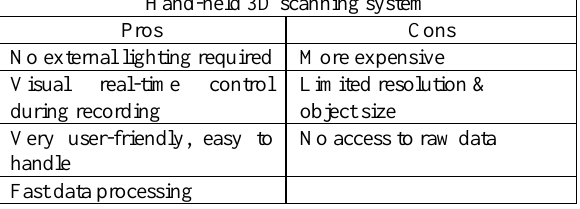
Table 7. Advantages and disadvantages of hand-held 3D scanning